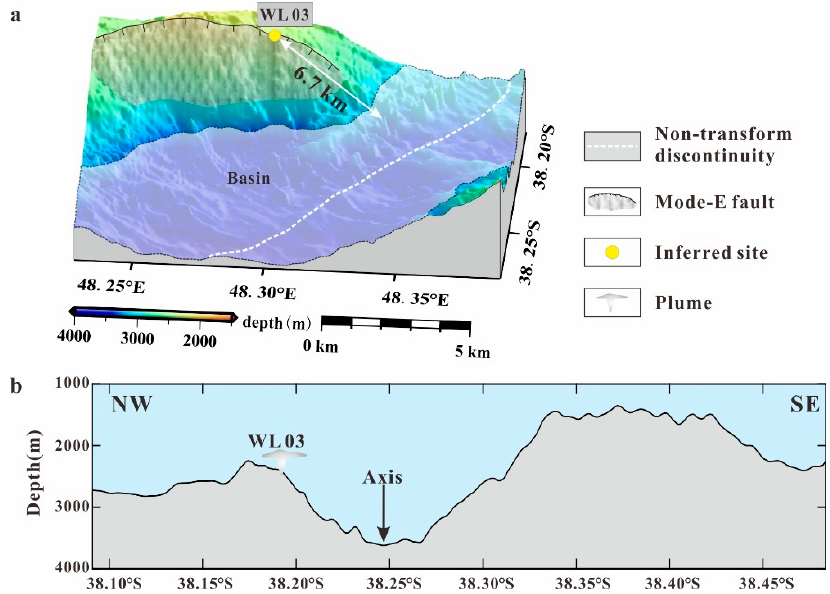
Figure 8. Location of site WL03 for the western NTD. ( a ) Three-dimensional view around site WL03. The transparent area indicates an axial basin. ( b ) Location of site WL03 shown in schematic profile perpendicular to the ridge axis.